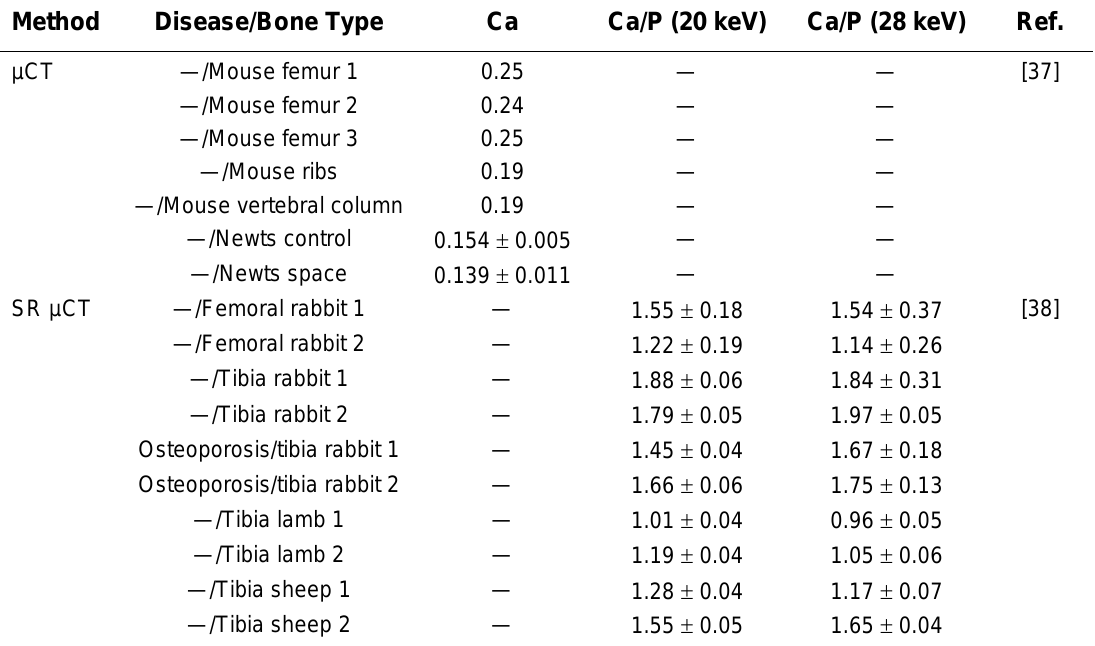
Results for the Ca Content and the Ca/P Ratio Derived from the